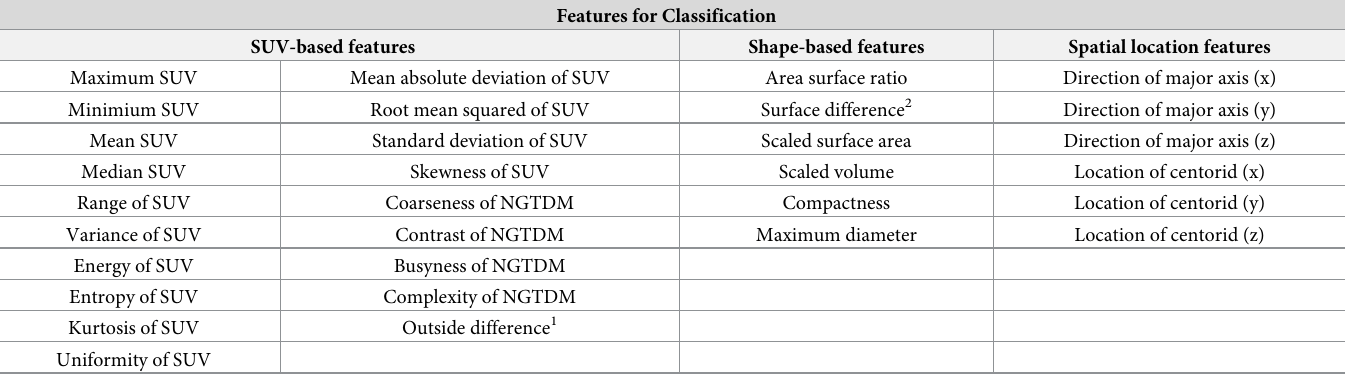
Table 1. Features of the segmented volumes used for